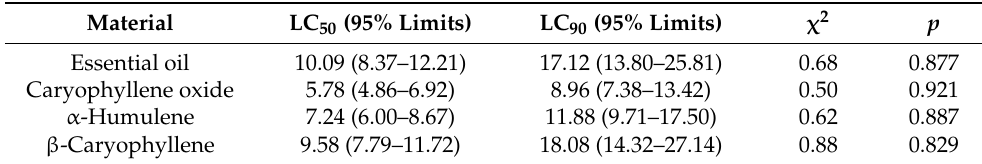
Table 6. Molluscicidal activity of Croton hirtus essential oil and its major components against Physella acuta adults ( µ g/mL).